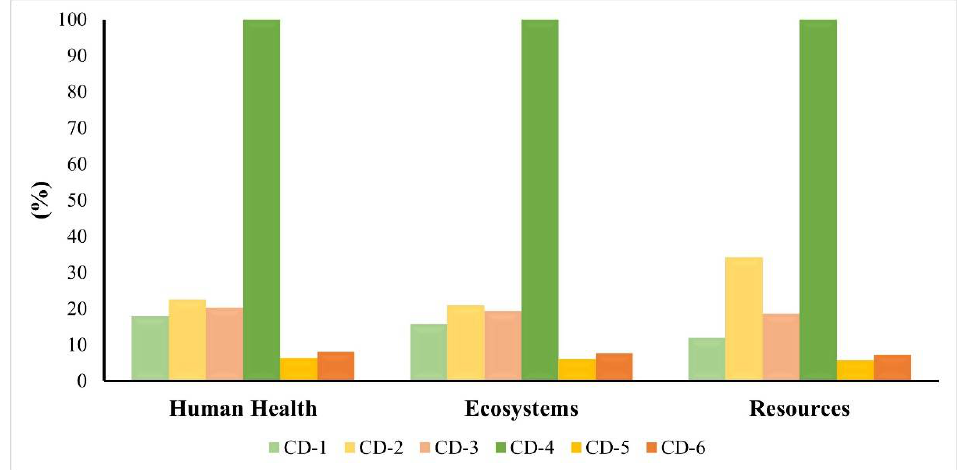
Figure 2. Relative environmental impacts of syntheses under study for incineration disposal scenario, applying ReCiPe method. Green scale refers to hydrothermal treatments; Yellow scale refers to microwave-assisted treatments; Orange scale refers to calcination treatments.